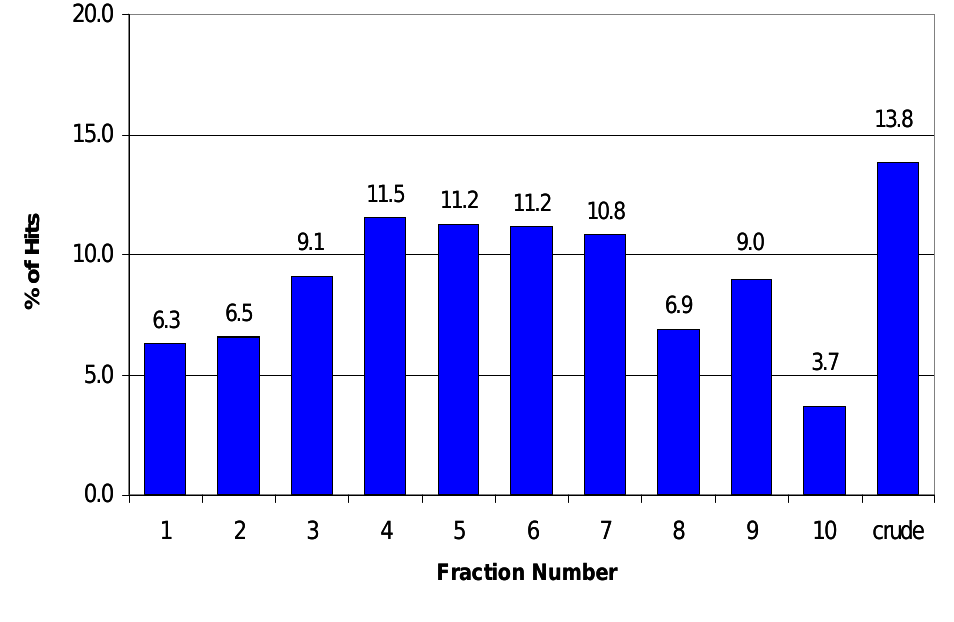
Figure 5 . Distribution of the hits across fractions for nine HTS assays (total number of hits = 2750).